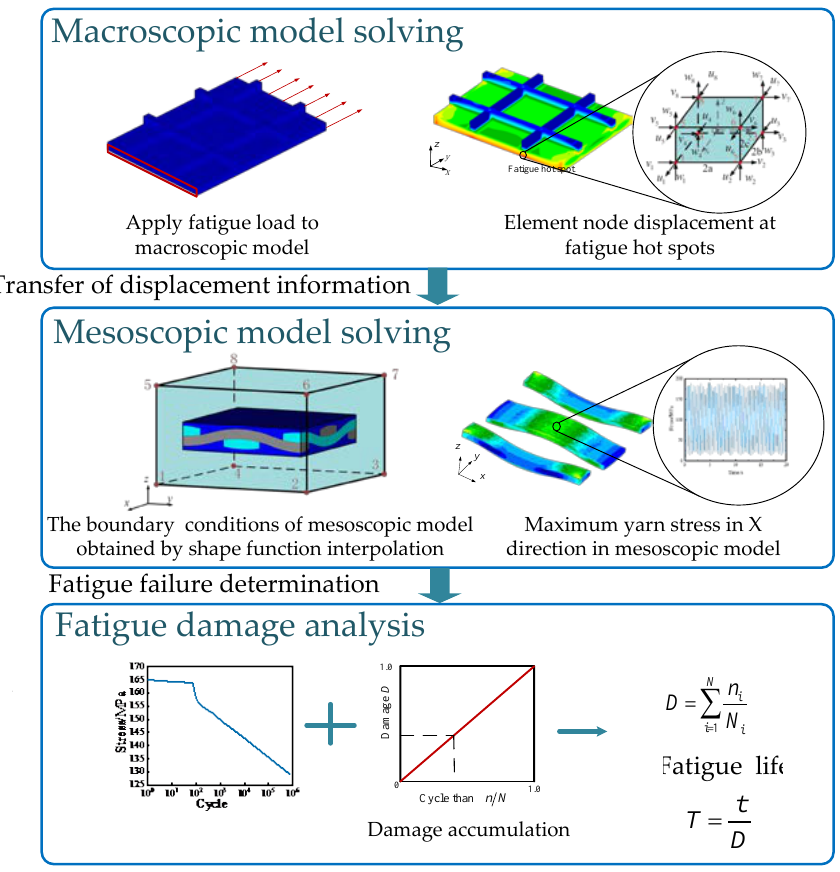
Figure 3. Flow chart of multi-scale fatigue analysis method for ceramic matrix composites based on dynamic sub-model.